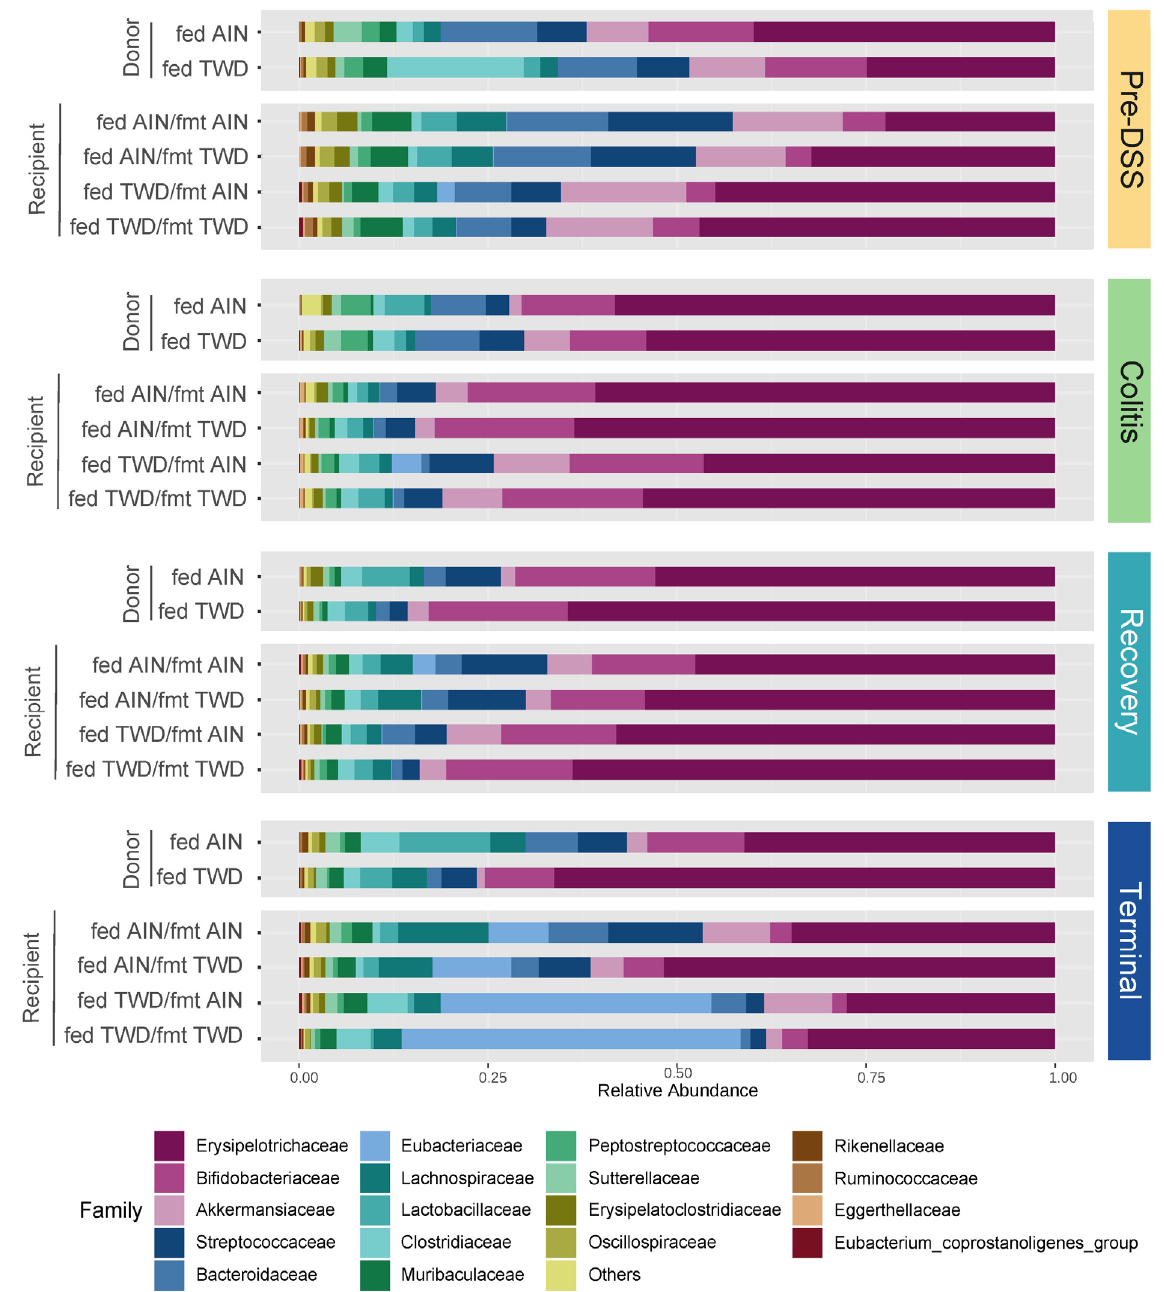
Figure 4. Taxonomic classification of mouse fecal bacteria. The data shown are the average relative normalized abundance of bacteria annotated to the family taxonomic level for the top 18 most abundant taxa for each experimental group at each time point ( n = 19 to 20 cages per group at the pre-DSS time point, n = 17 to 18 cages per group at the active colitis time point, n = 12 to 13 cages per group at the recovery time point, and n = 7 to 8 cages per group at the terminal time point). The donor fecal microbiome sequence data are obtained from Rodriguez et al. [22]. However, the donor sequence data were reprocessed in conjunction with the recipient fecal microbiome sequence data in this study so that the normalization for both donor and recipient data sets was consistent. The data for the phylum taxonomic level are available in Figure S4.